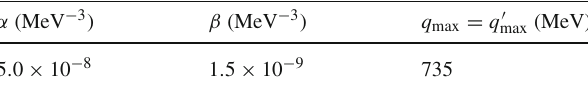
Table 3 Values of the wave function at the origin for the two s-wave channels